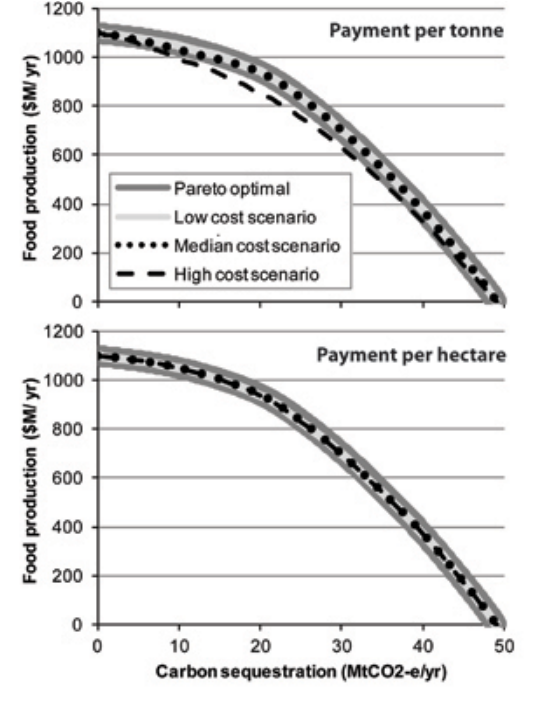
Fig. 7 . Sensitivity of food-carbon trade-offs and efficiency of the payment schemes to changes in economic